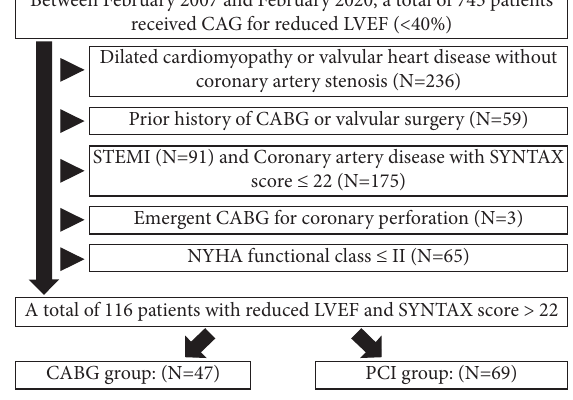
Figure 1: Flowchart of the patient selection process. Abbreviations: CAG: coronary angiography, LVEF: left ventricular ejection fraction, CABG: coronary artery bypass graft, STEMI: ST-segment elevation myocardial infarction, and PCI: percutaneous coronary